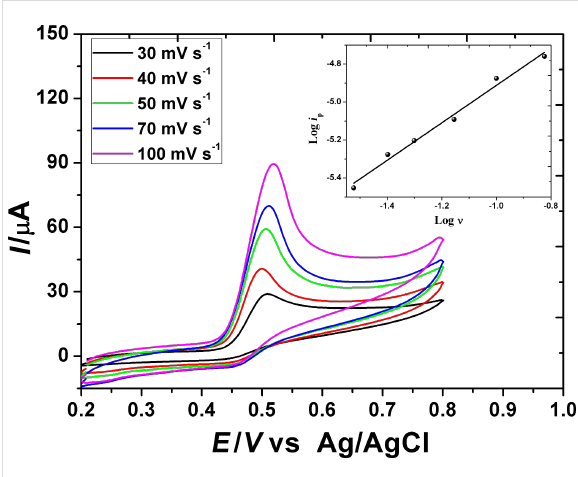
Figure 5: Effect of scan rate on the cyclic voltammograms recorded for the first wave of 1.0 mM GA on the PGA/MWCNT/GCE modified elec- trode in 0.2 M H 3 PO 4 (pH 2.0). Inset: log i pa –log relationship.